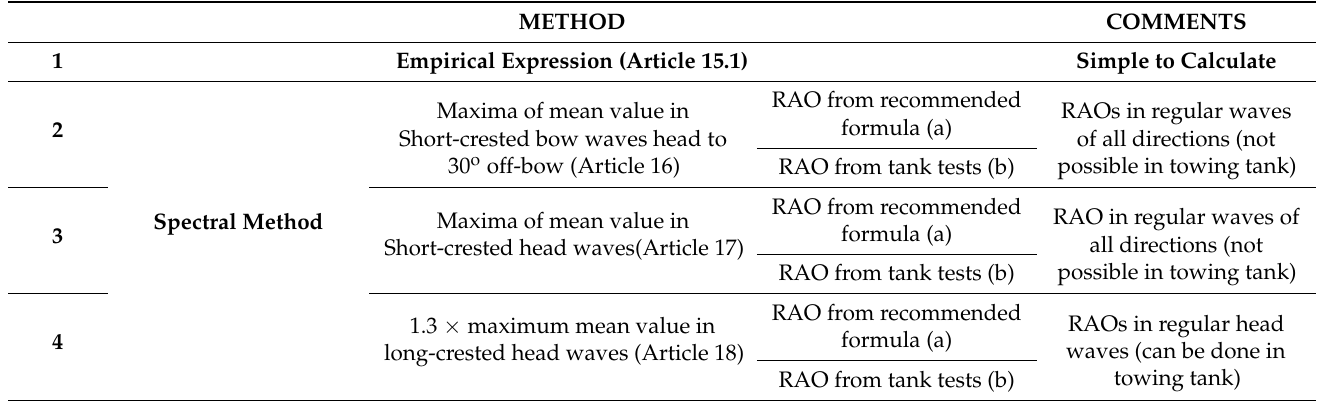
Table 2. Methods for wave added resistance